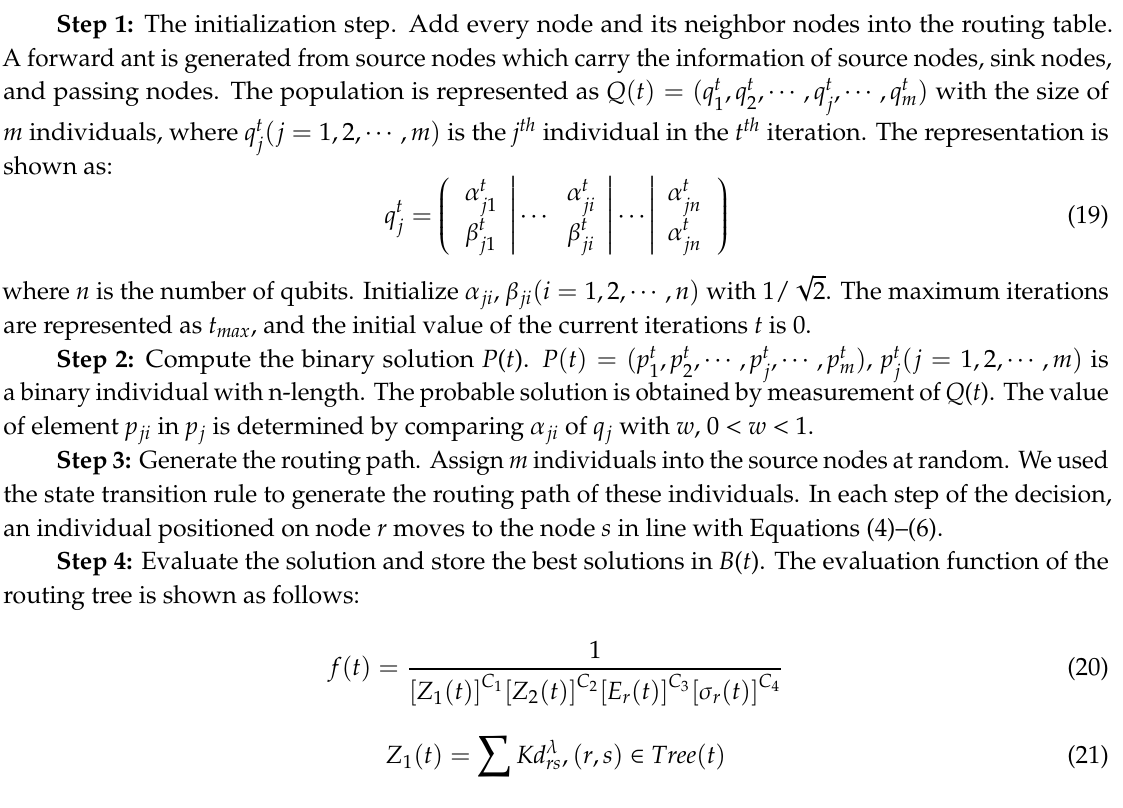
Figure 4. The process of the Quantum Ant Colony Multi-Objective Routing (QACMOR) approach.